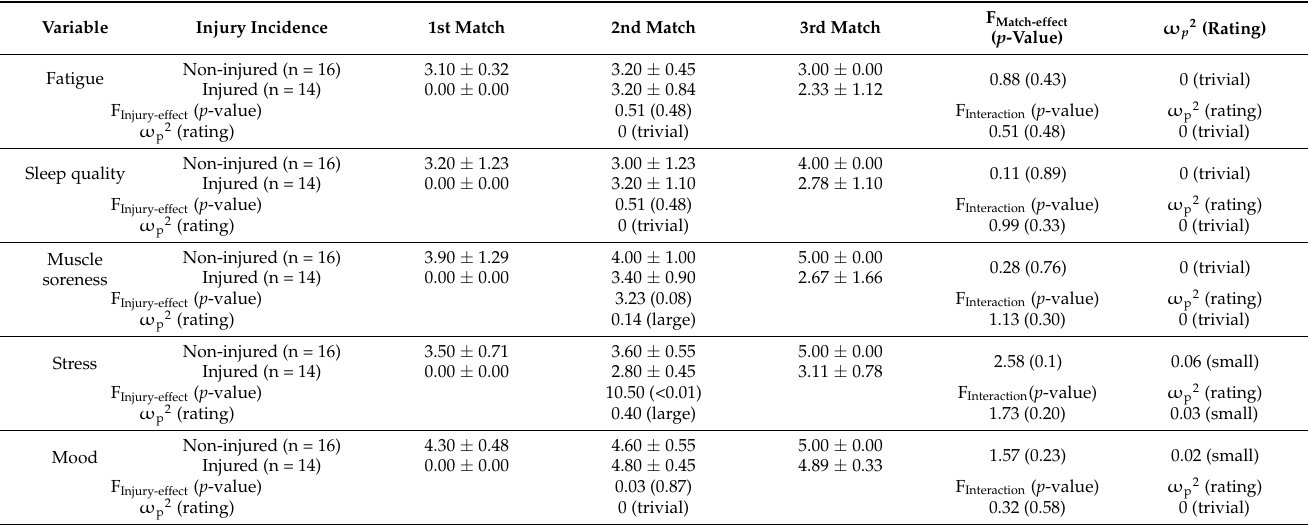
Table 3. Raw data of wellness scores by match and injury